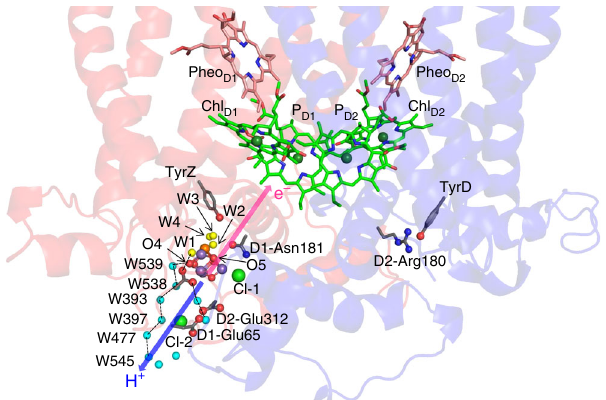
Fig. 1 Proton and electron transfer pathways near Mn 4 CaO 5 . Blue and pink arrows indicate proton and electron transfer pathways proceeding from the Mn 4 CaO 5 cluster,